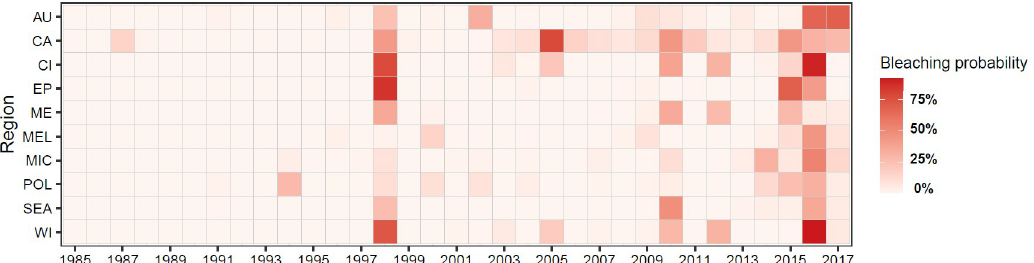
Fig 3. Mean bleaching probability across all coral reefs cells by year and region.